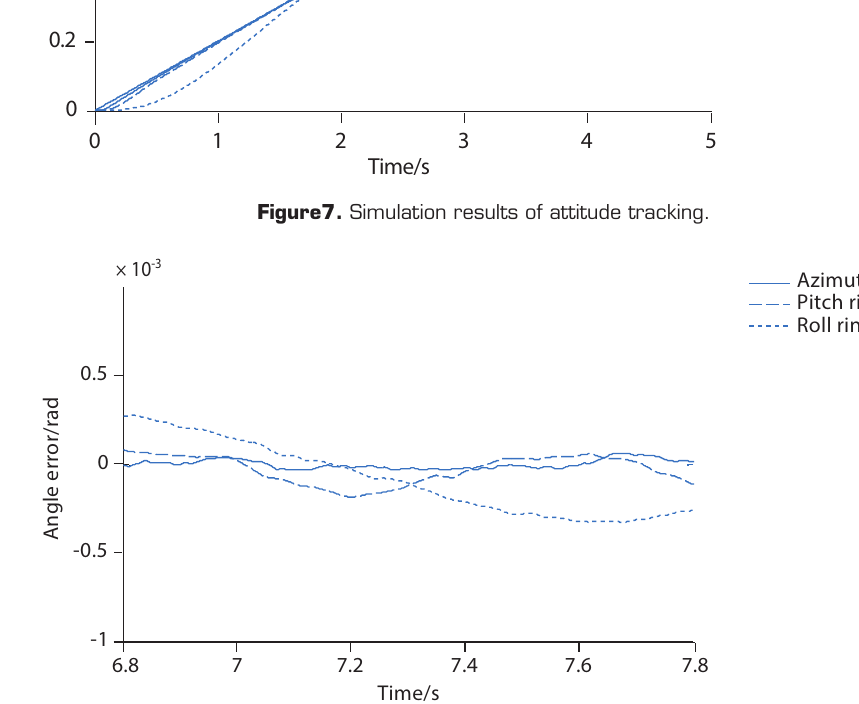
Figure7. Simulation results of attitude tracking.